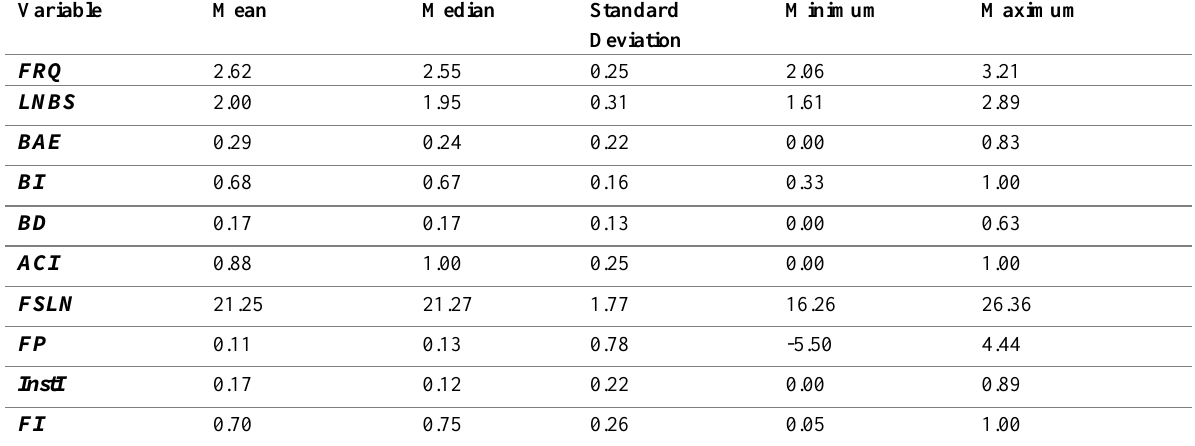
Table 2: Descriptive Statistics for Dependent and Independent